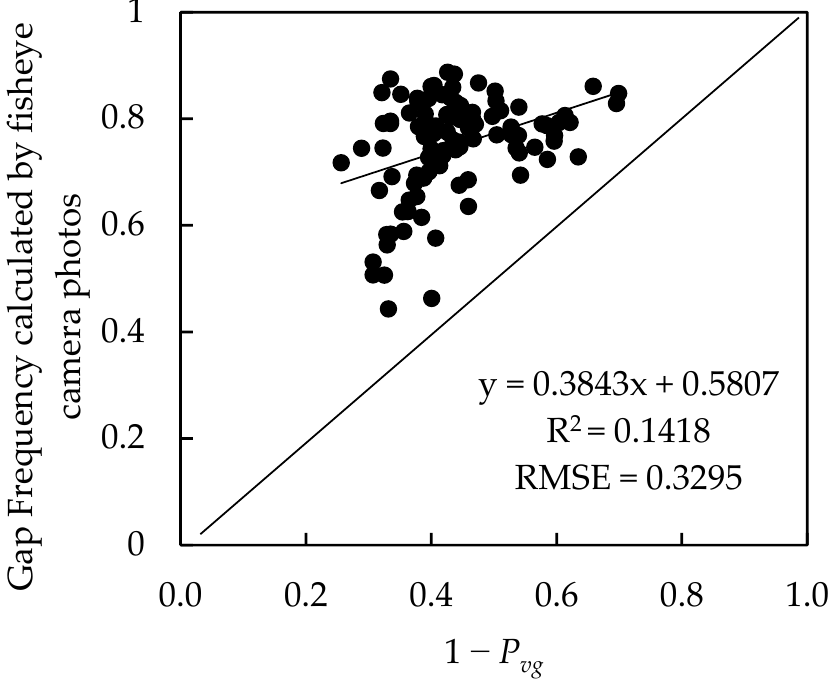
Figure 9. Scatter plot between canopy closure measured by fisheye camera images and 1 − P vg .